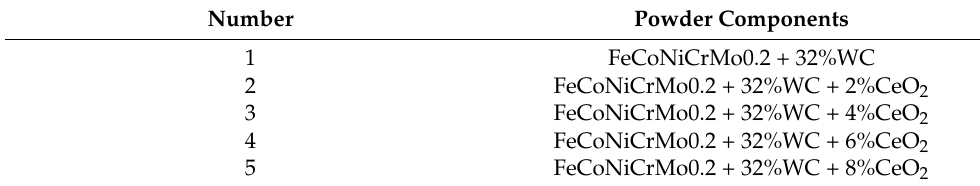
Table 3. Chemical composition of CeO 2 composite powder with different contents.